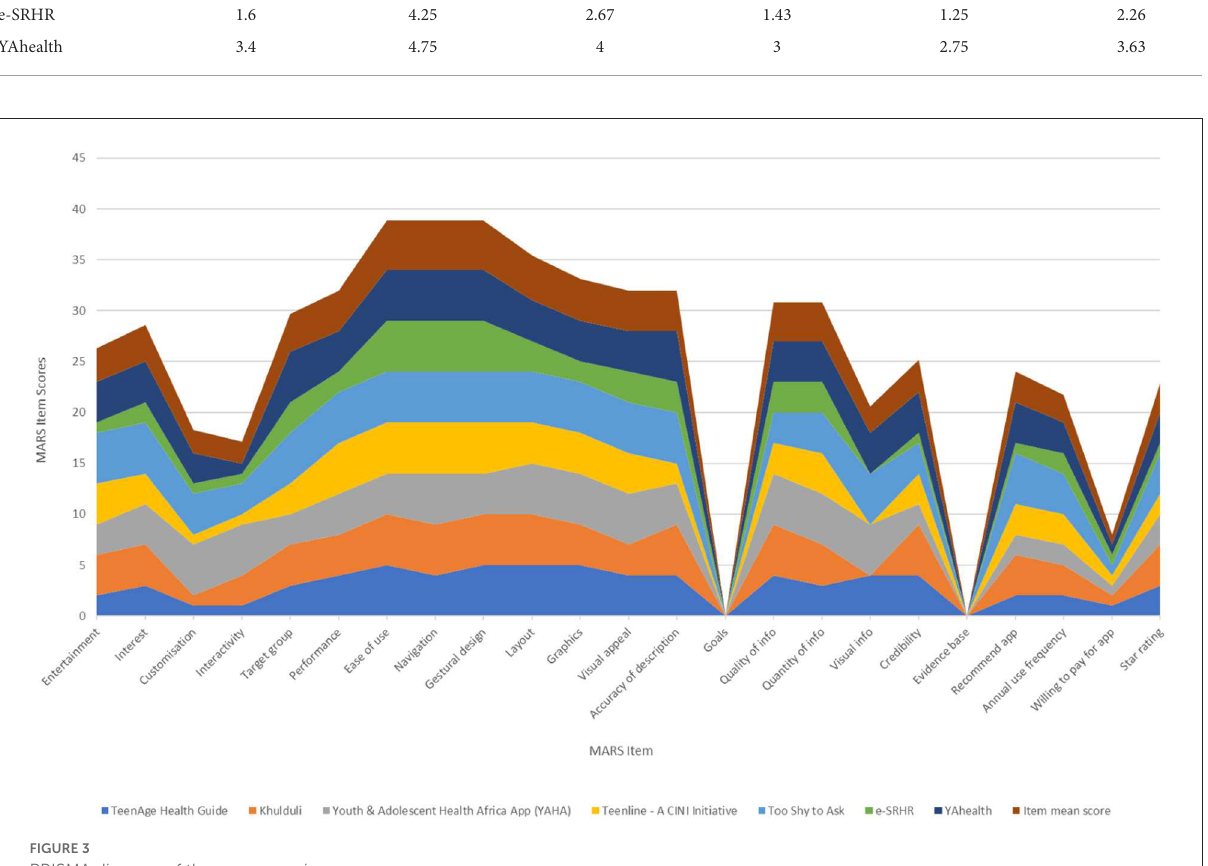
FIGURE3 PRISMA diagram of the app screening